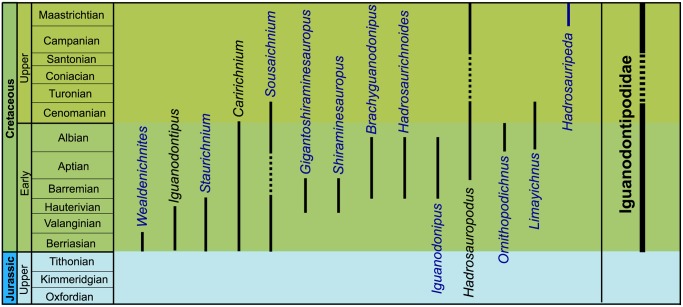
Temporal distribution of ichnogenera included in Iguanodontipodidae.The ichnogenera in black are considered systematically valid. The ichnogenera in blue are considered systematically non-valid but the tracks belong to Iguanodontipodidae (see explanation in the text). Discontinuous line, there are no data.